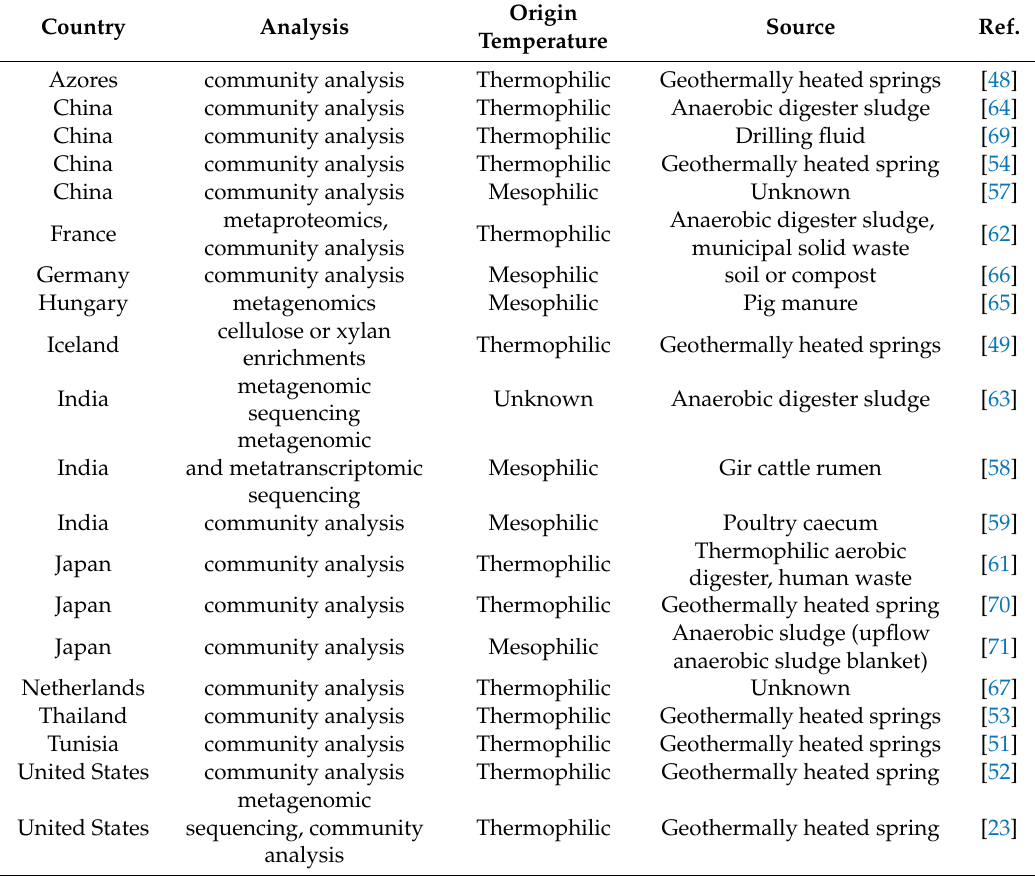
Table 2. Published Caldicellulosiruptor metagenomics or community